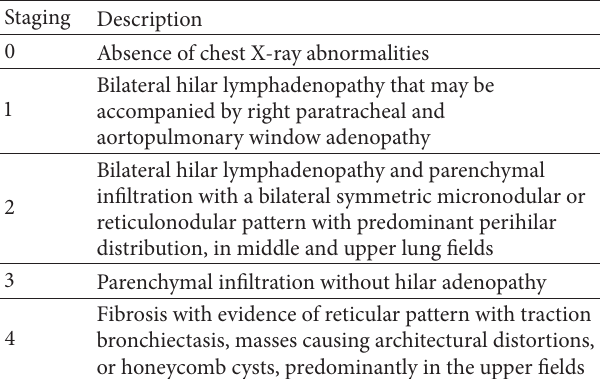
Table 1: Staging of pulmonary sarcoidosis based on chest X-ray.